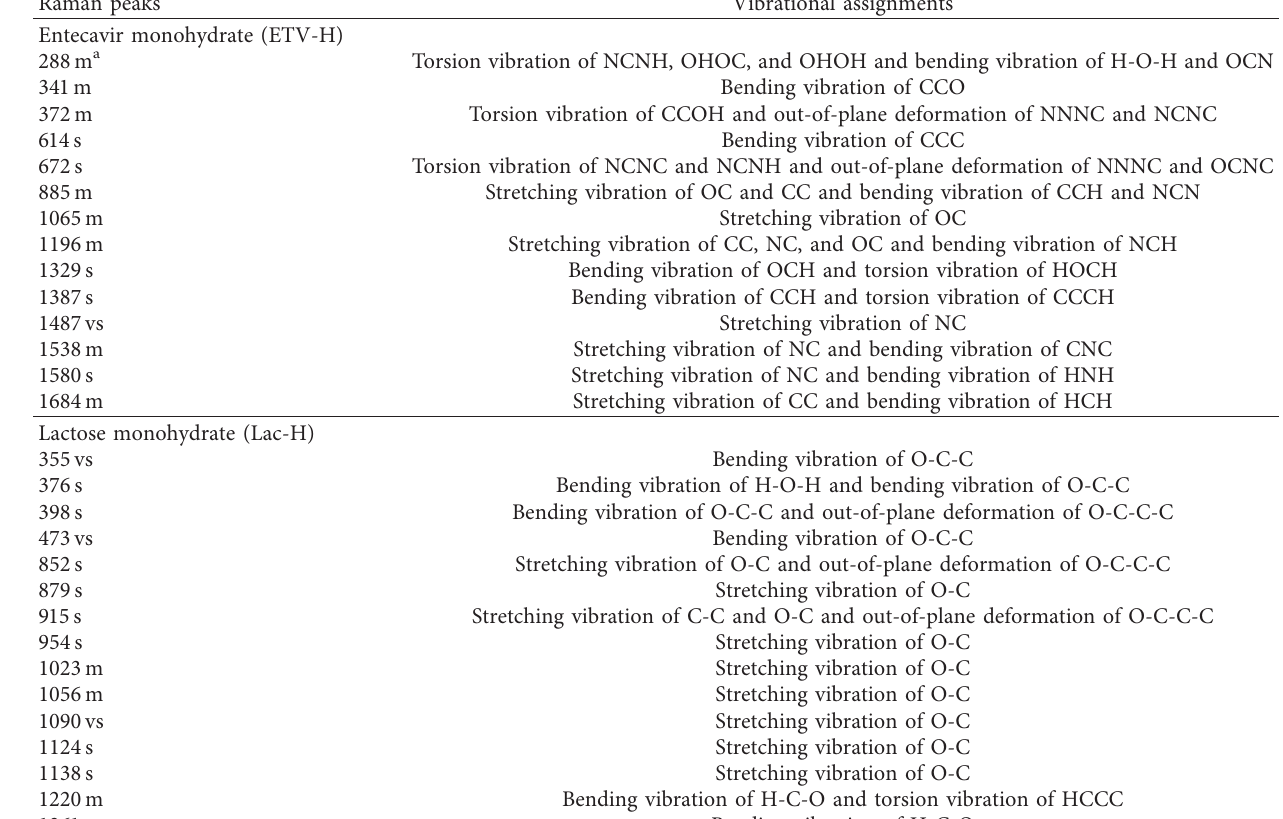
Table 2: The assignments of Raman characteristic peaks for ETV-H and all excipients used in Baraclude tablets. Raman